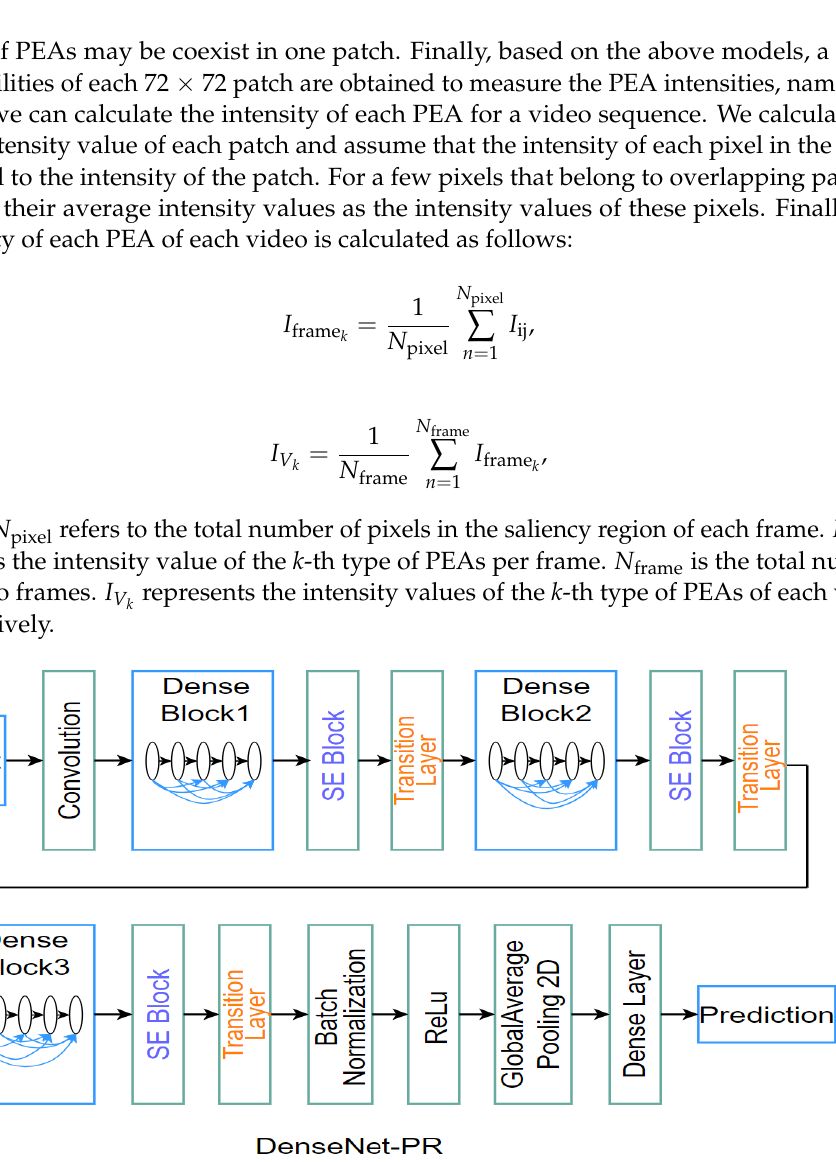
Figure 8. The structure of the DenseNet-PR [1]. (© 2020 IEEE)